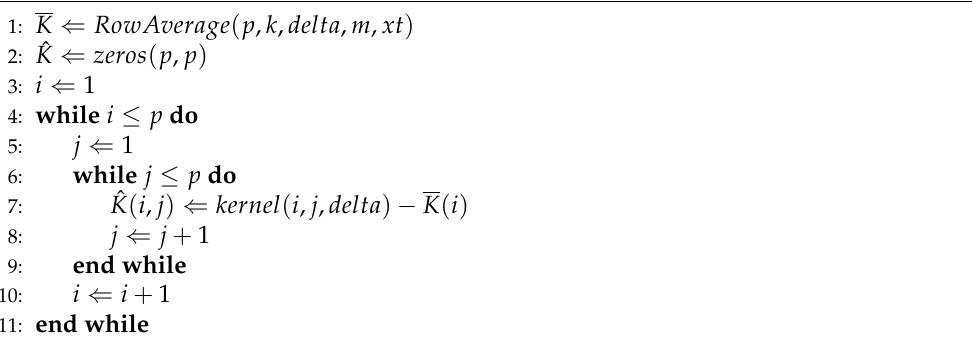
Algorithm 3 Calculate ˆ K = KH ( xt , p , kernel , delta , m